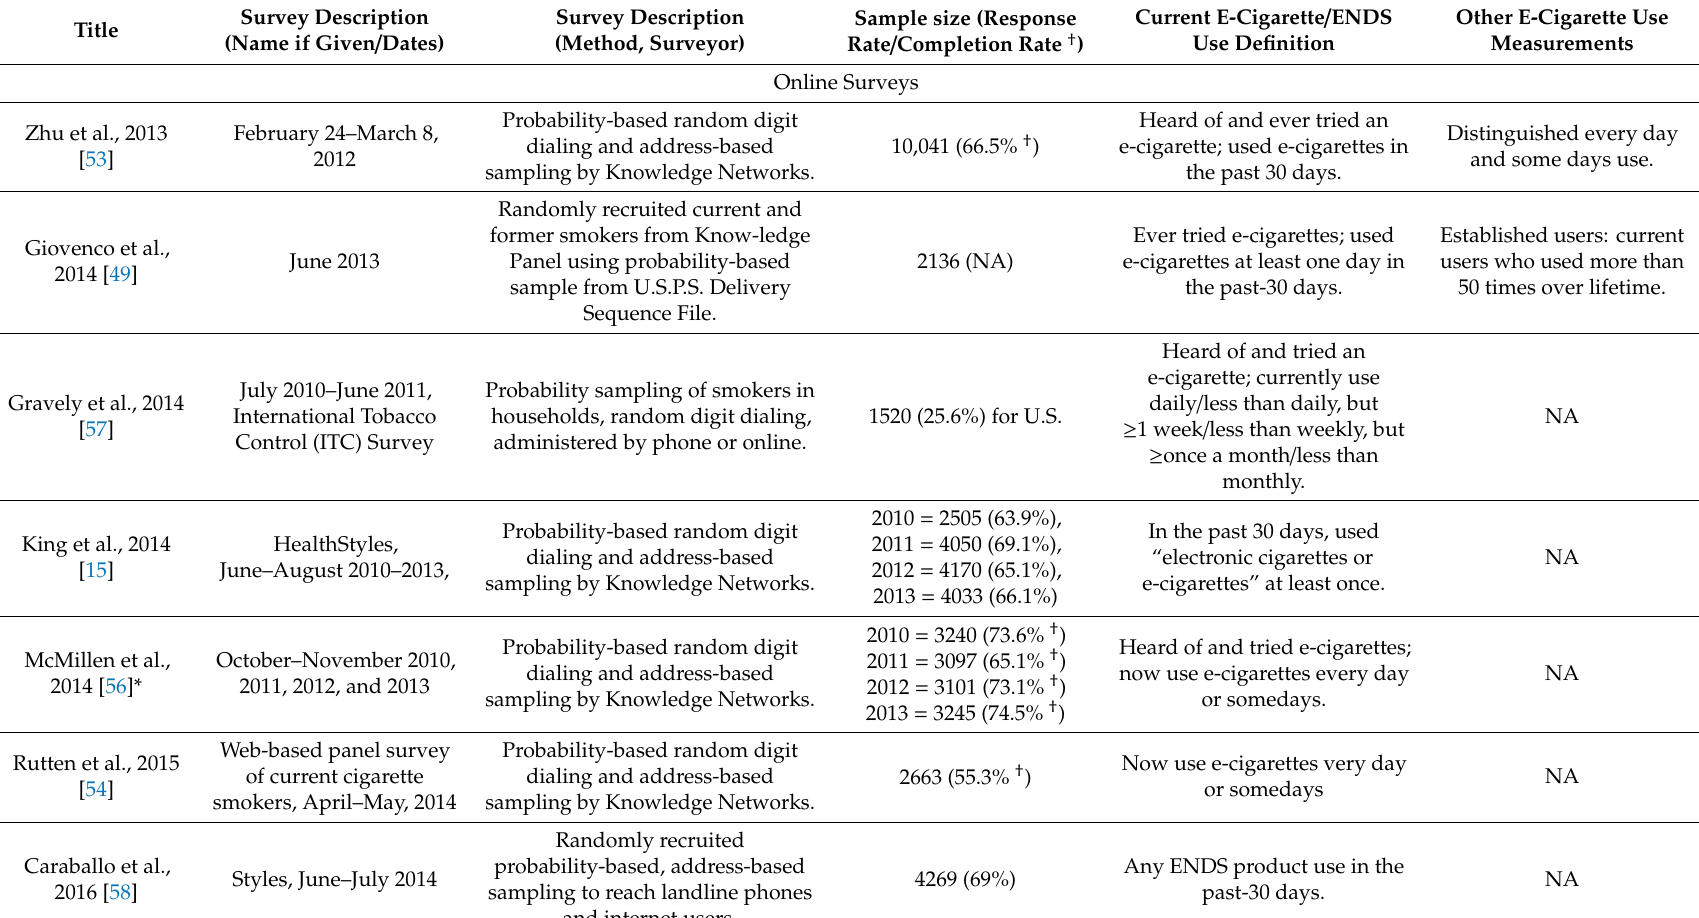
Table 1. U.S. nationally representative surveys of current adult e-cigarette